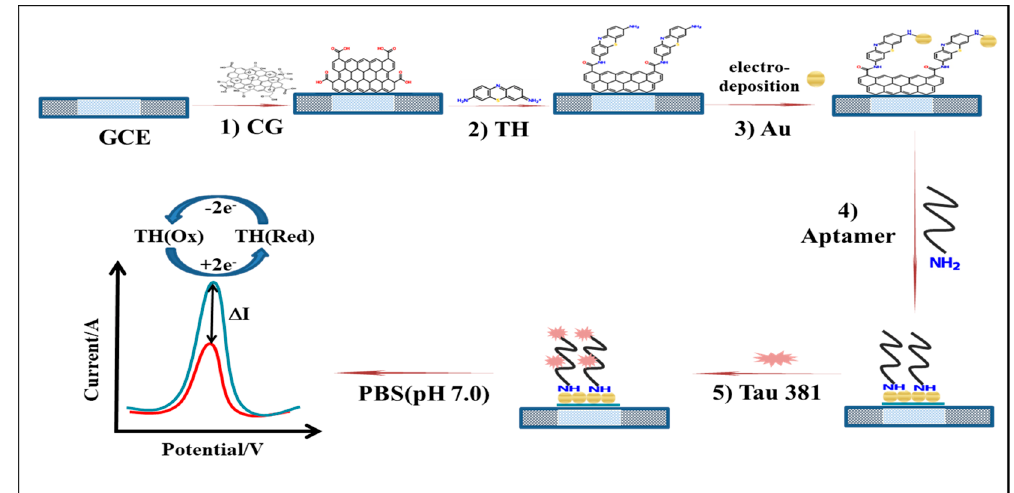
Figure 1. The structure and reversible reaction of